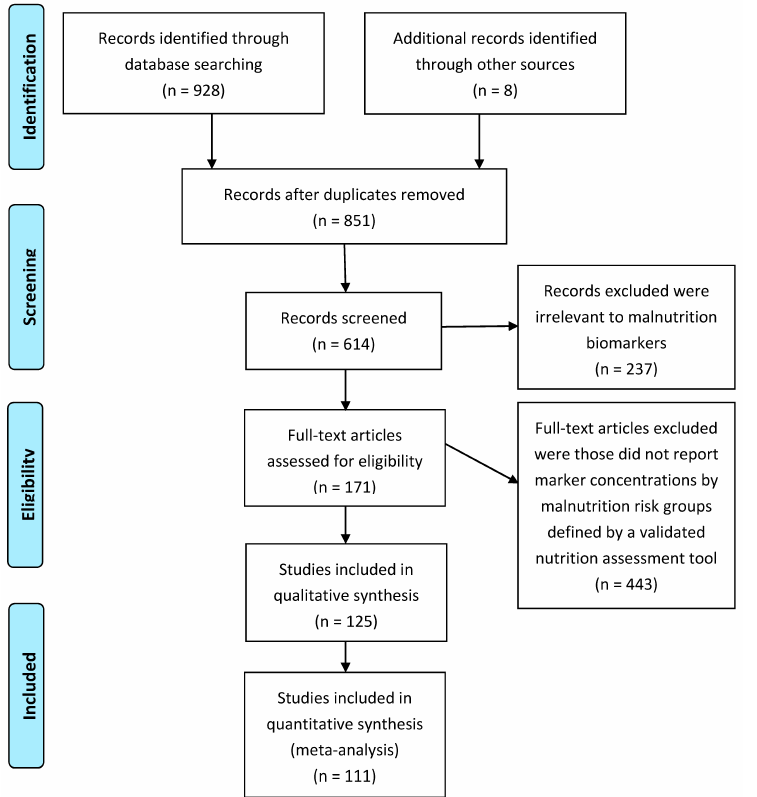
Figure 1. Flow diagram of the search and review process.